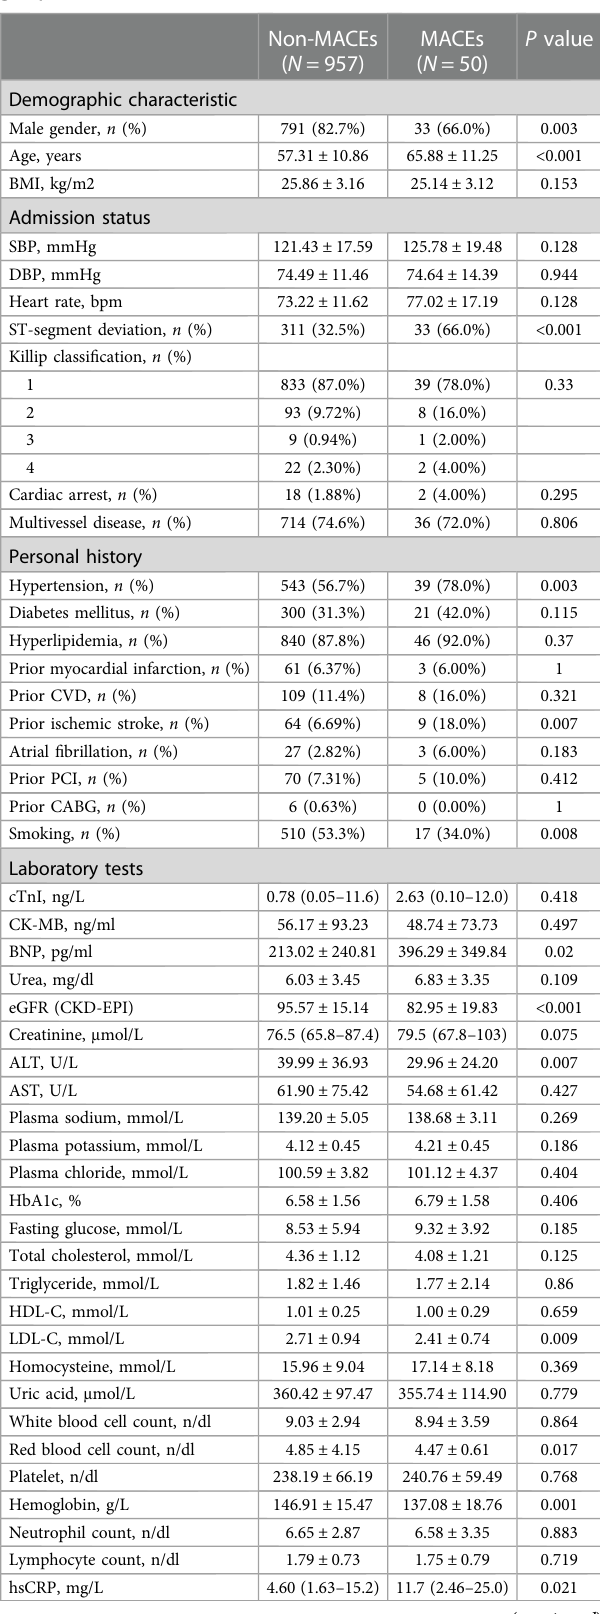
TABLE 1 Clinical characteristics between MACEs group and non-MACEs